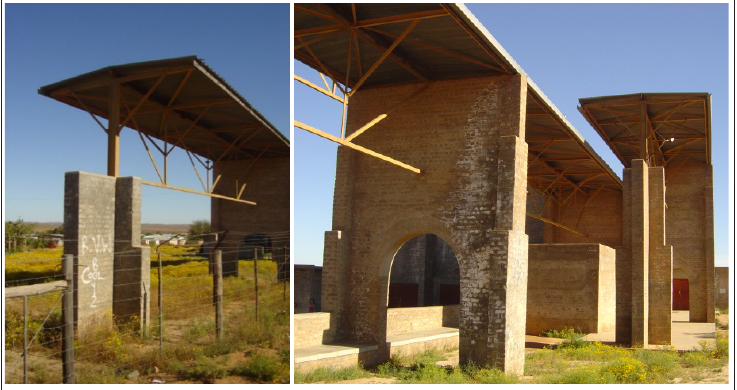
Figure 9: No maintenance on the cement brick-constructed Steinkopf Community Centre in the Northern Cape Province, South